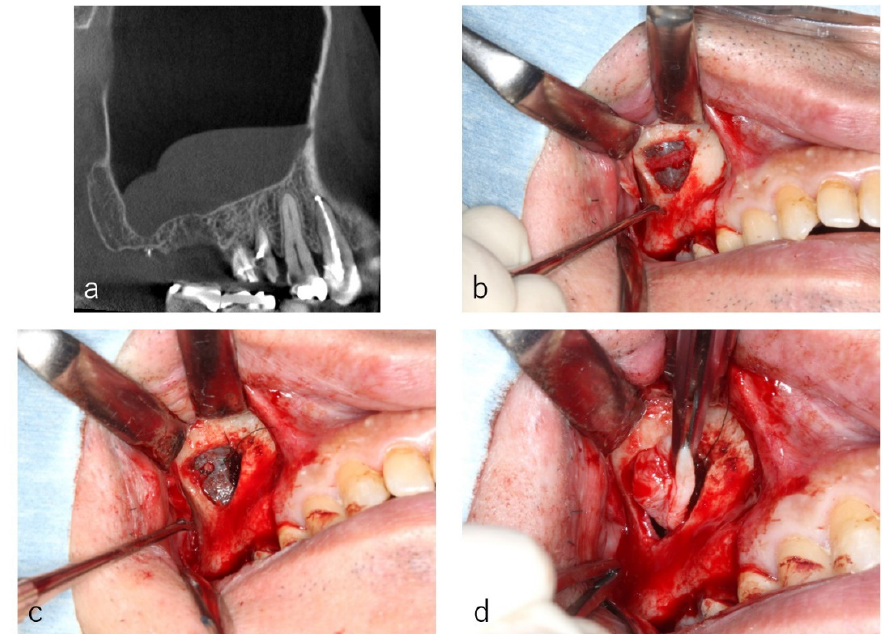
Figure 4. Case: 55 years old male. A sagittal section of the CT image showed two well-defined ‘dome-shaped’ faintly radiopaque lesions ( a ). At the window, the posterior superior alveolar artery was denuded ( b ), and the blood vessel was ligated and amputated ( c ). The cystic lesions were enucleated through the window ( d ).